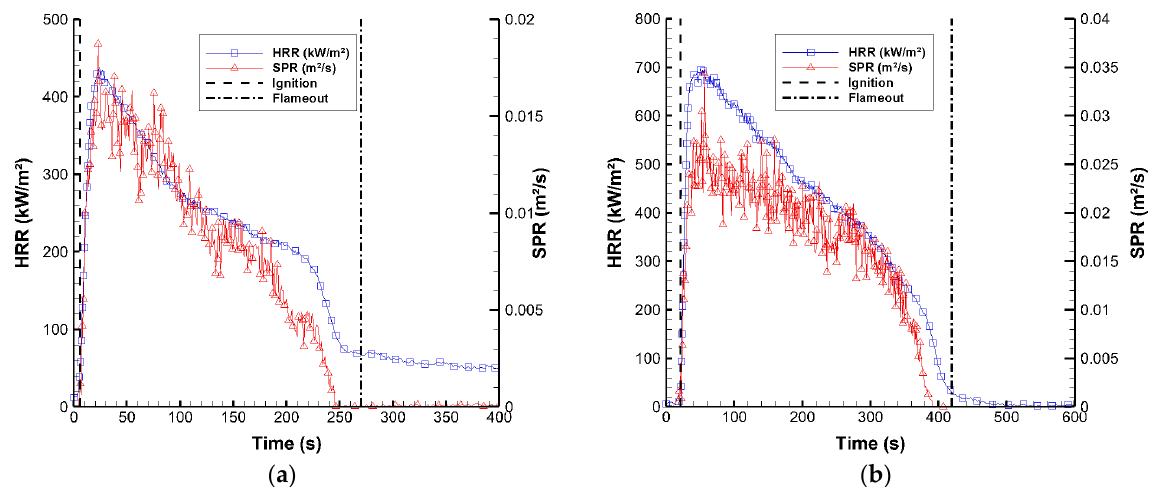
Figure 10. HRR and SPR for an imposed heat fl ux of 50 kW/m 2 for ( a ) wood and ( b ) thermoplastic samples.